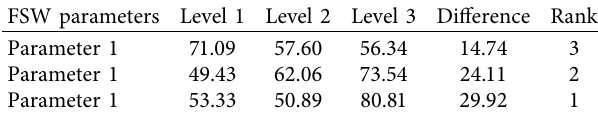
Table 4: Response table for mean (traverse force).